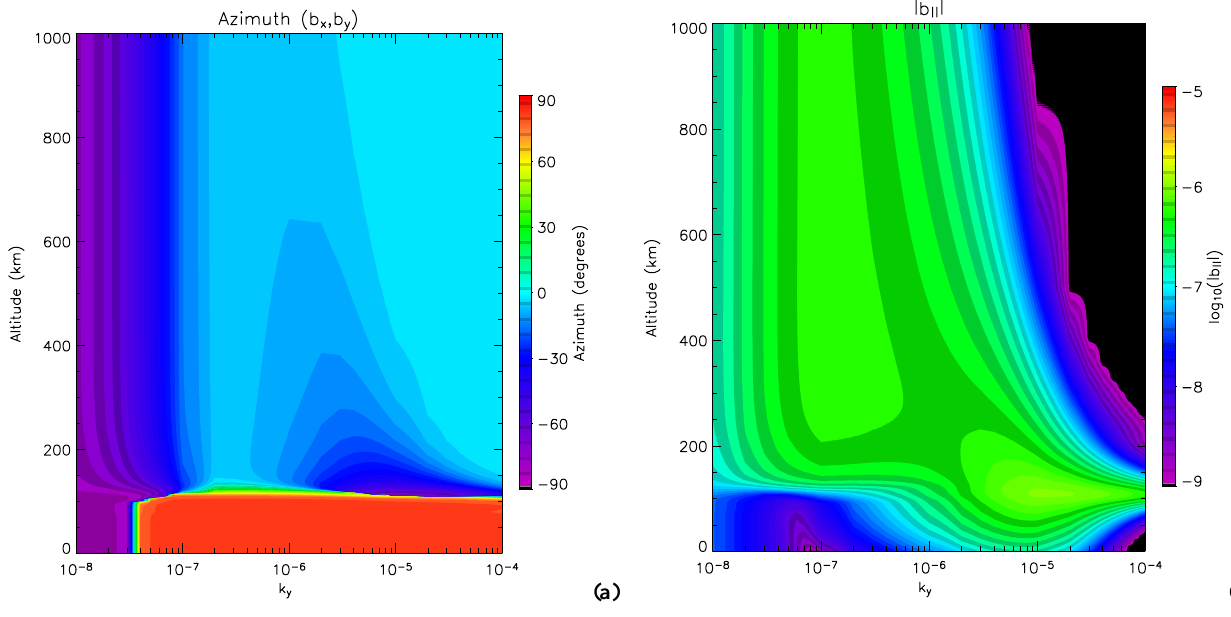
Fig. 5. Polarisation azimuth between the ULF wave b x and b y components for a frequency of 16mHz, dip angle of I = 70 ◦ and solar max- imum ionosphere conditions. (a) Wavenumbers are k x = 10 − 10 m − 1 and k y varying between 10 − 8 m − 1 and 10 − 4 m − 1 . (b) The amplitude of the field aligned (compressional) component of the ULF wave magnetic field for the parameters in